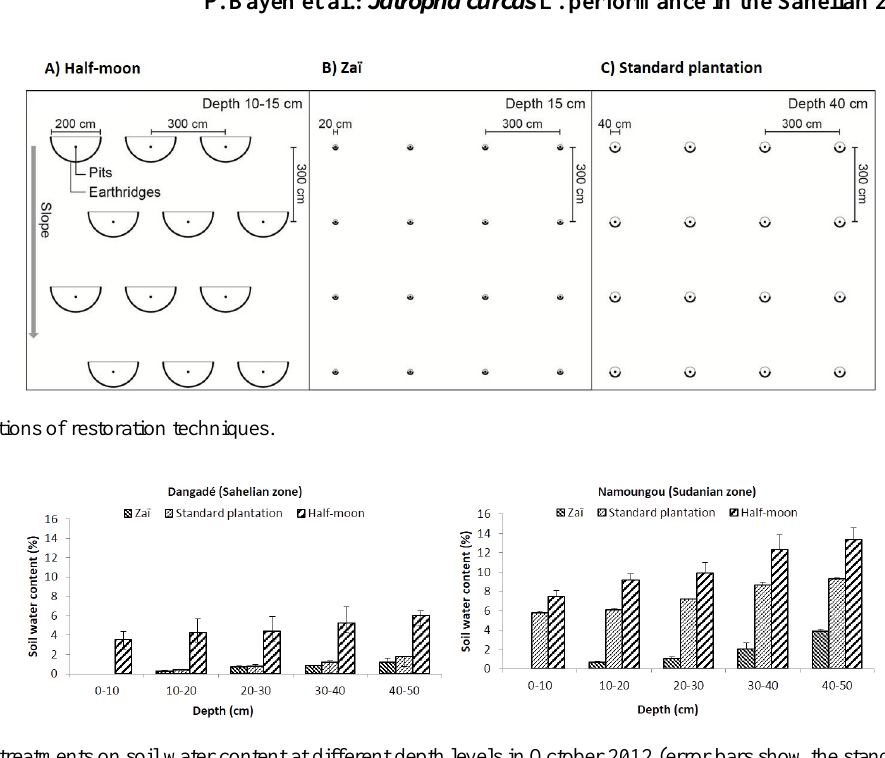
Figure 4. Effect of treatments on soil water content at different depth levels in October 2012 (error bars show the standard deviation).